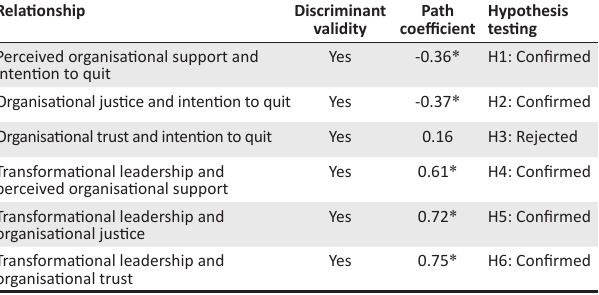
TABLE 2: Discriminant validity and relationships between latent variables.